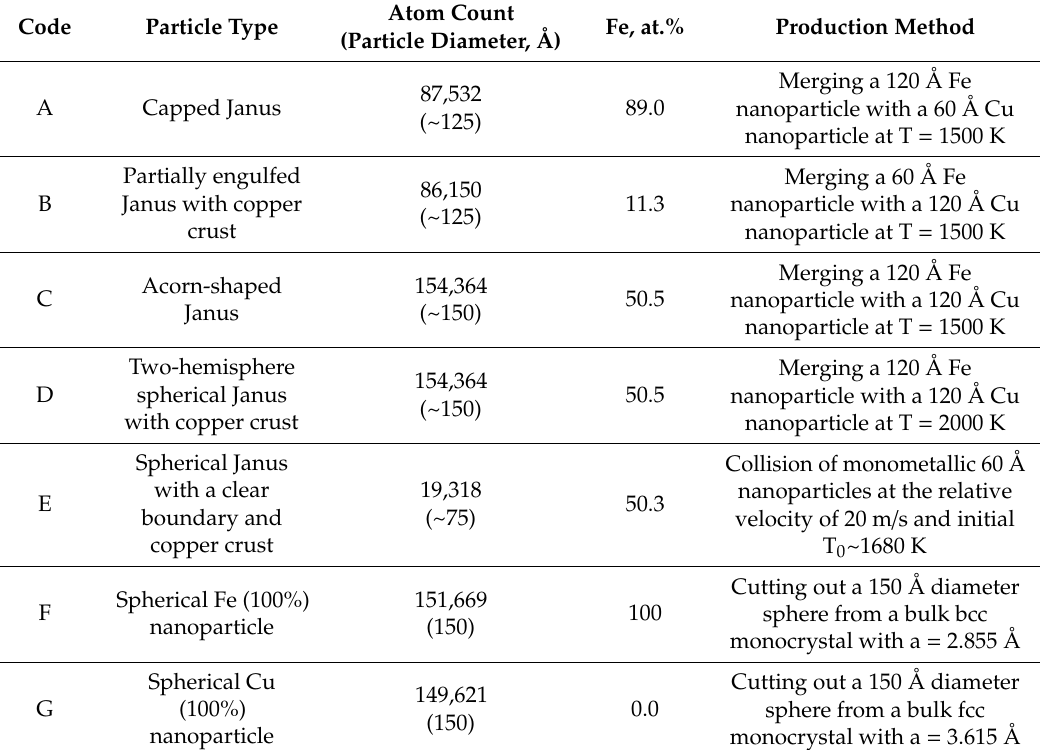
Table 1. A set of seven model nanoparticles used for building the models of initial Fe–Cu powders. Model bimetallic A–E nanoparticles were obtained in work